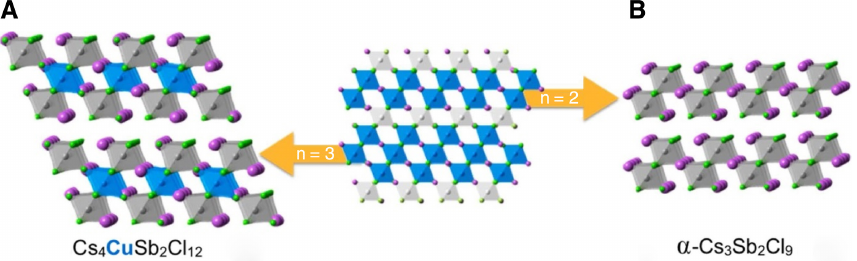
B X , which can be obtained by cutting along the (111)-direction n + 1 n 3 n + 3